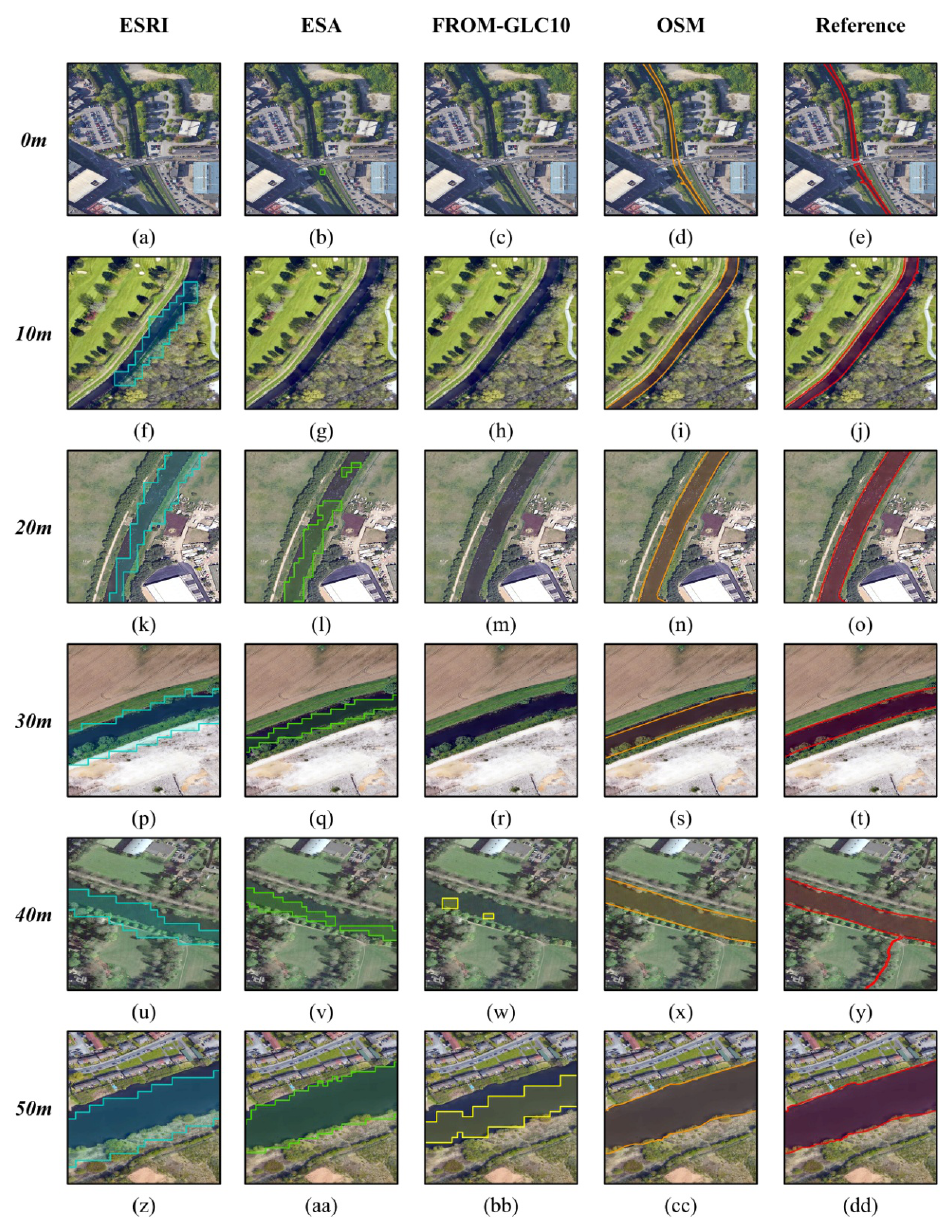
Figure 6. Comparison of using the four global open LULC datasets (ESA, ESRI, FROM-GLC, and OSM, highlighted in different colors) for blue space mapping by overlapping with Google Earth images. Different width thresholds were used for the analysis: ( a – e ) 0m; ( f – j ) 10m; ( k – o ) 20m; ( p – t ) 30m; ( u – y ) 40m; ( z – dd ) 50 m.